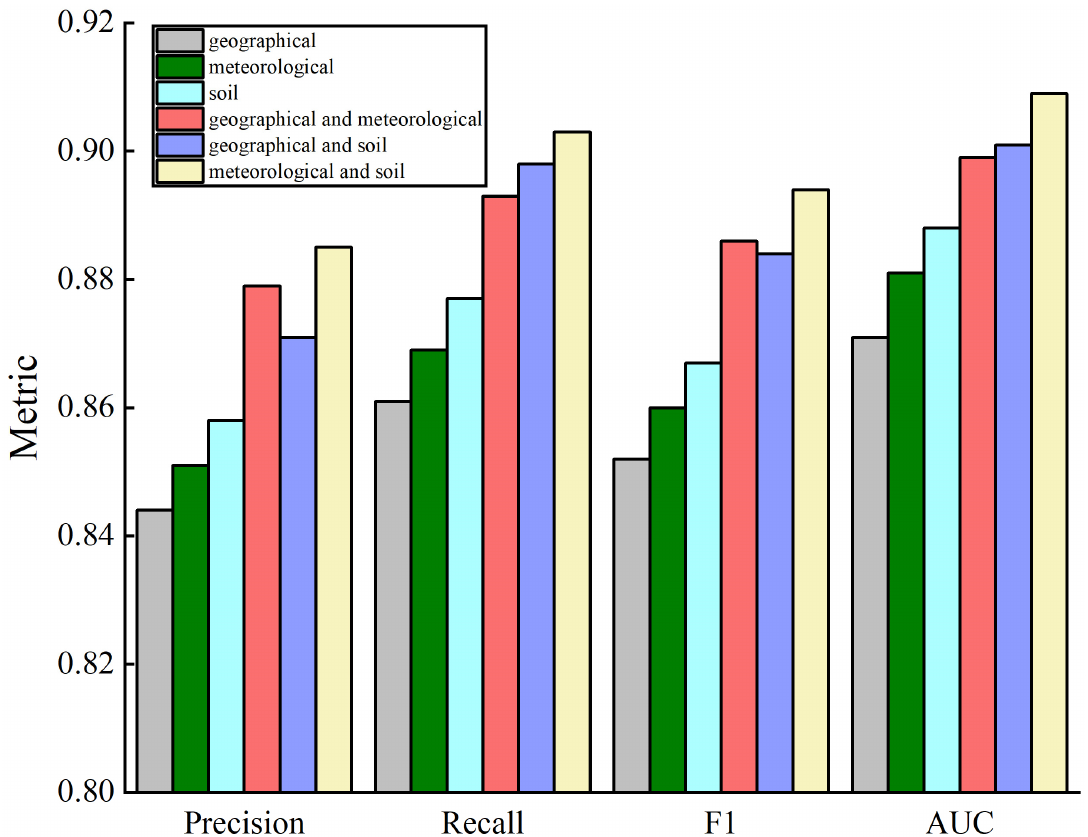
Figure 13. Comparison of models based on inputs from different environmental factor datasets.